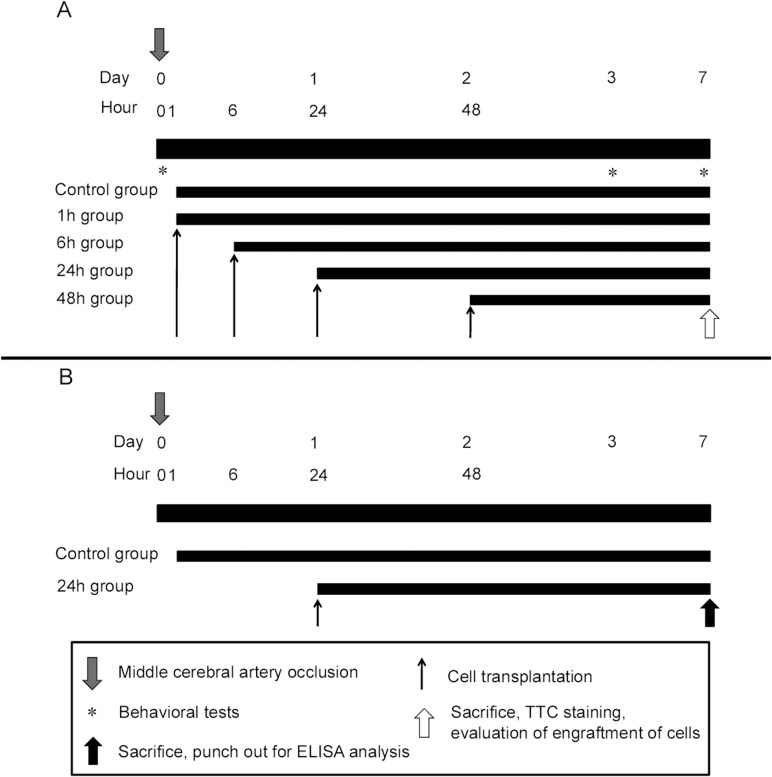
Time course.A: Schematic diagram showing overall experimental design. B: Schematic diagram showing experimental design for protein assay.